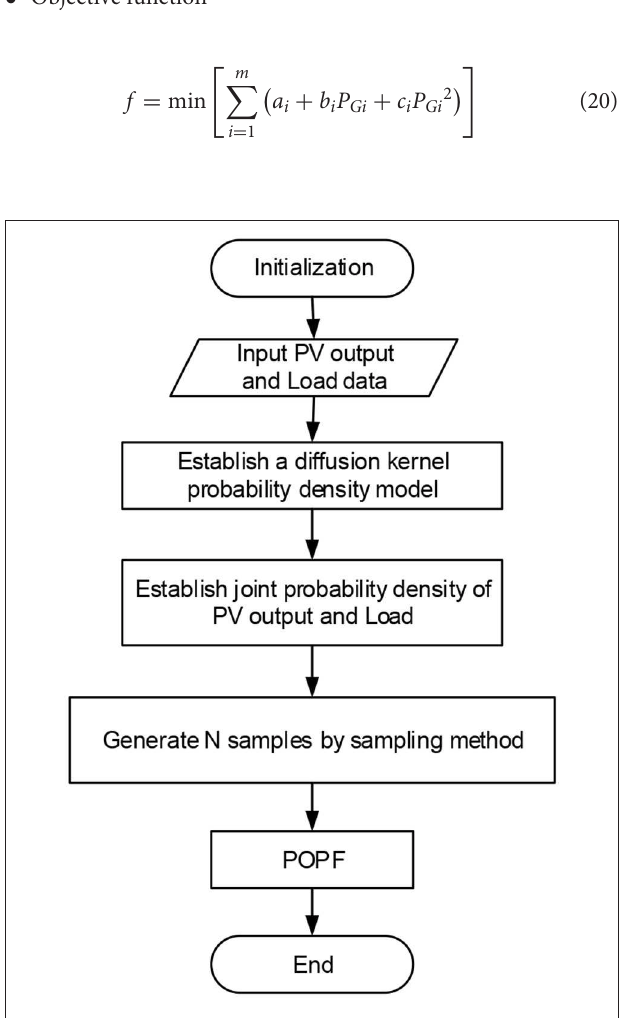
FIGURE 6 | Flowchart of probabilistic optimal power